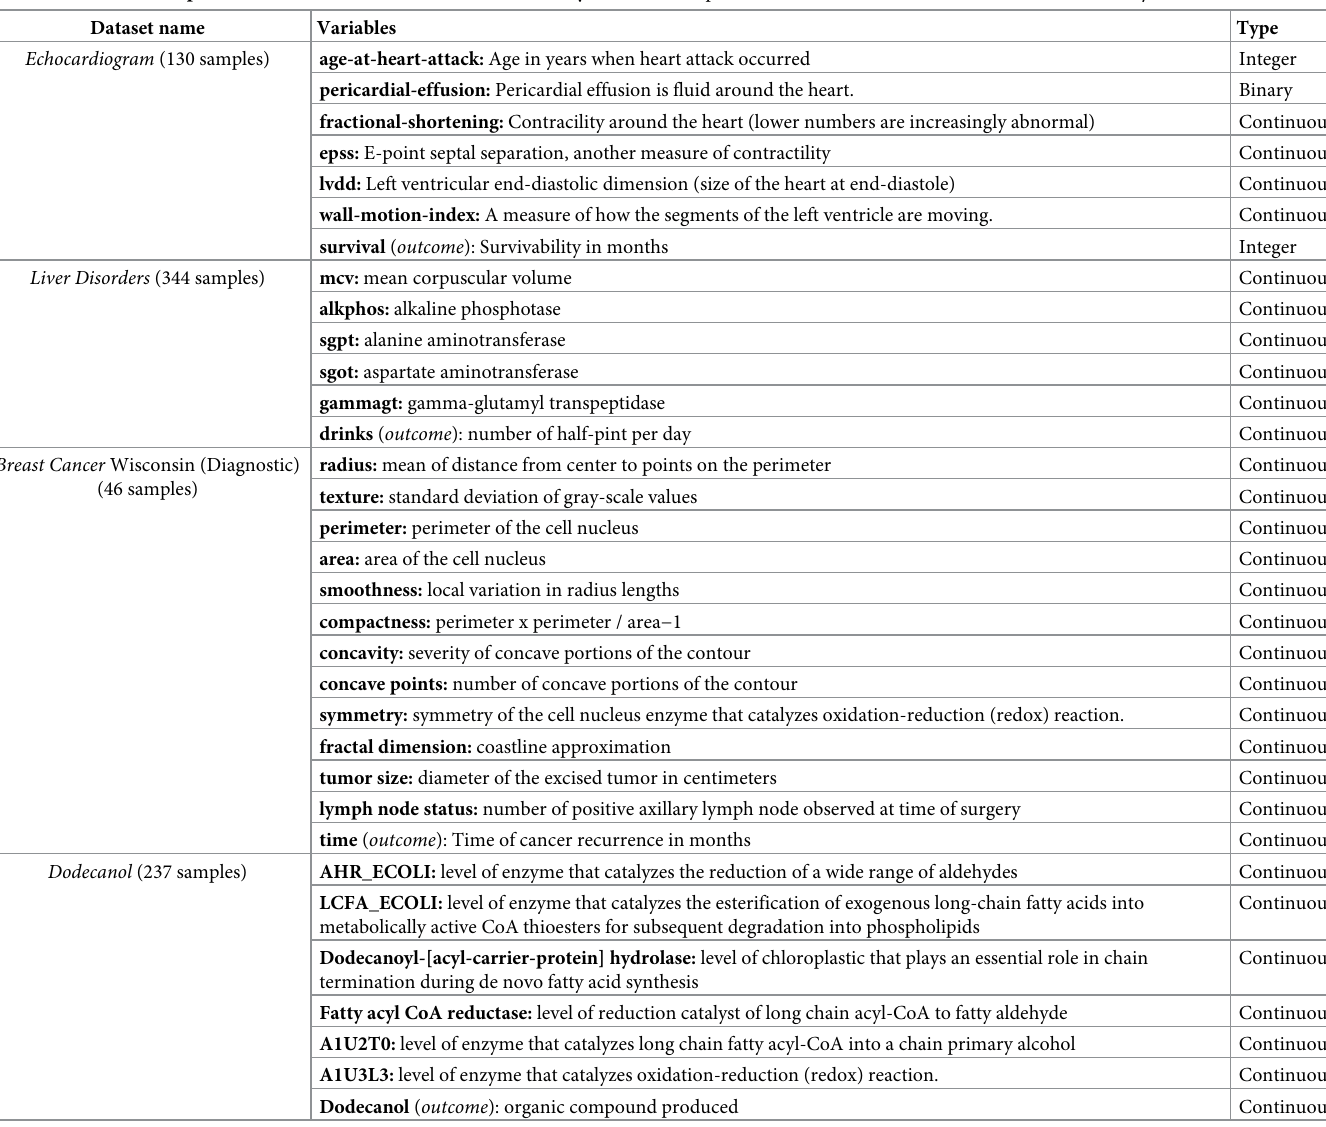
Table 2. Variable description for the four selected datasets for this study. Variables not presented in this table were removed due to redundancy/irrelevance. Dataset